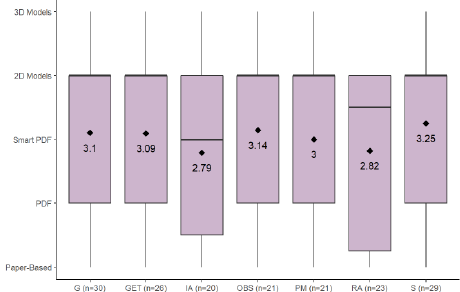
Figure 4 . Comparing state DOTs’ usage of different Data Formats across the different assets of the Roadside Asset Systems.